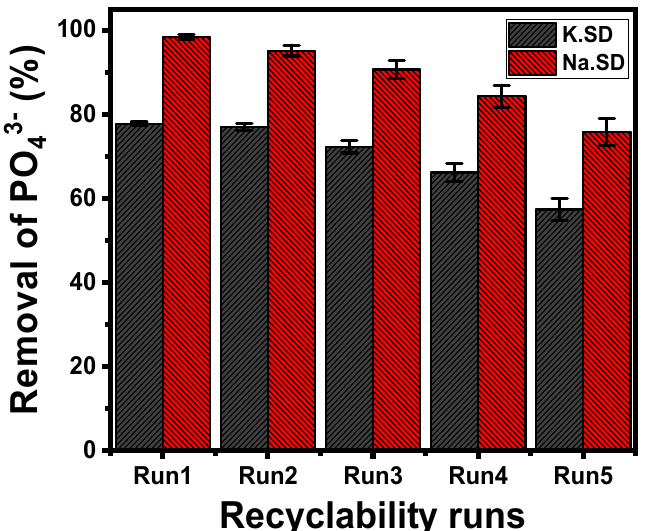
Figure 9. The recyclability properties of synthetic K.SD and Na.SD during the sequestration of PO 43– equation (pH 6, 50 mg L –1 phosphate concentration, 0.1 g L –1 dosage, and 960 min adsorption